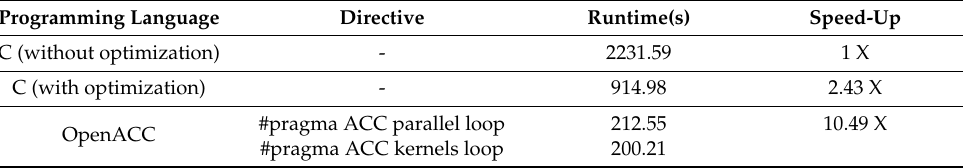
Table 2. Comparison of OpenACC directive.